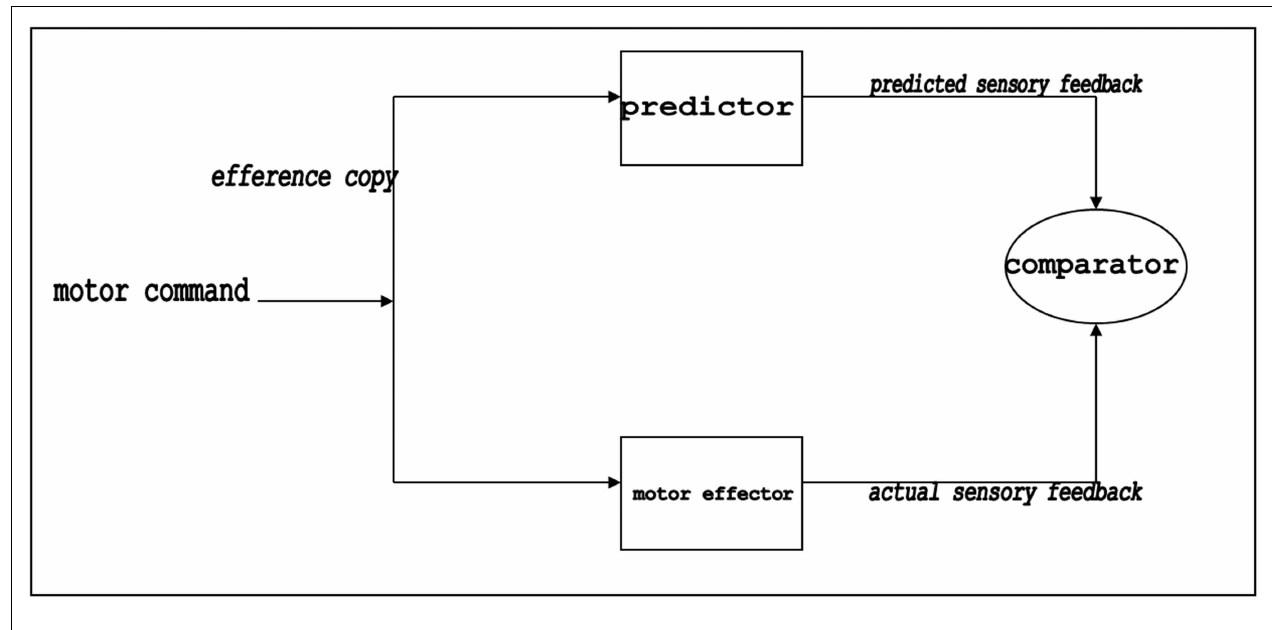
as a consequence of the prescribed motor execution. Upon effective execution, peripheral changes at the level of the muscles, the joints and the skin generate an actual proprioceptive feedback, which will (more or less) balance out the predicted sensory feedback in the (somato-)sensory cortices (at the level of a so-called